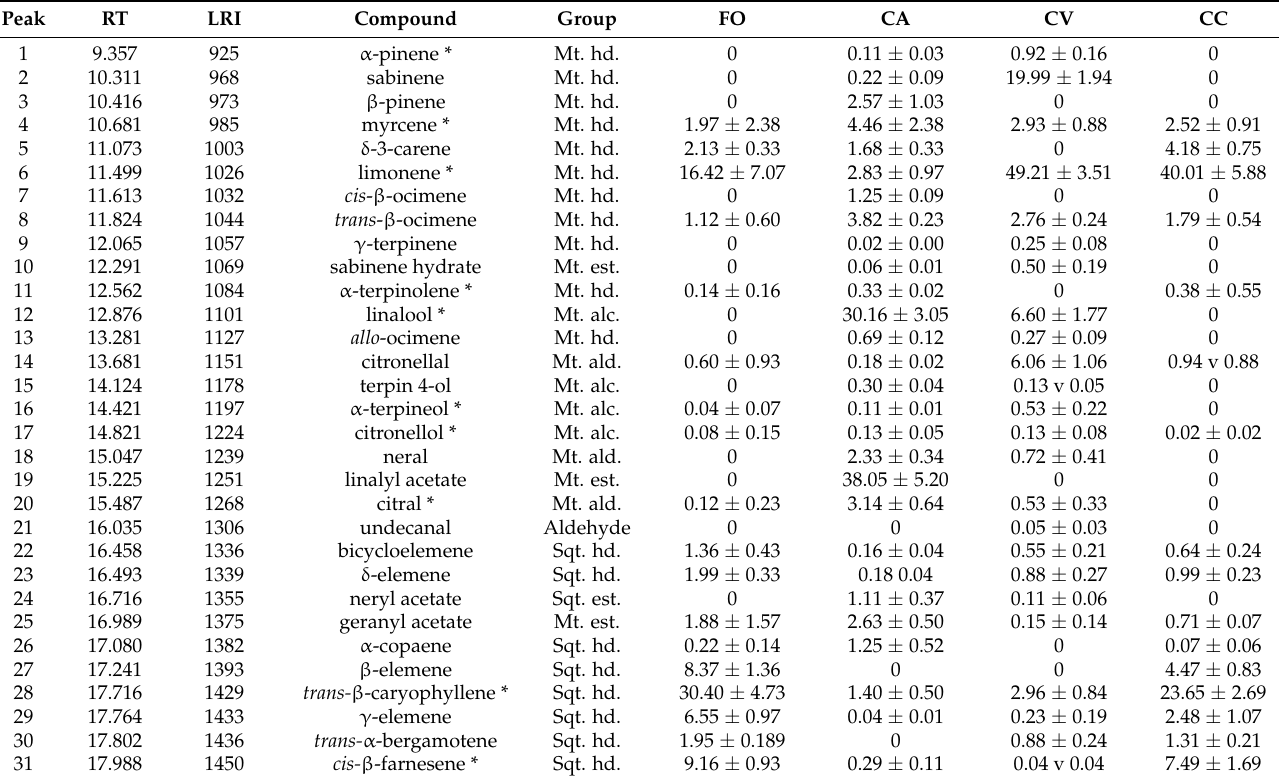
Table 1. Mean percentage ( ± SE) of the volatile organic compound (VOC) emission from C. aurantium (CA), C. volkameriana (CV), Carrizo citrange (CC), and Forner-Alcaide no. 5 (FO) collected via headspace SPME.